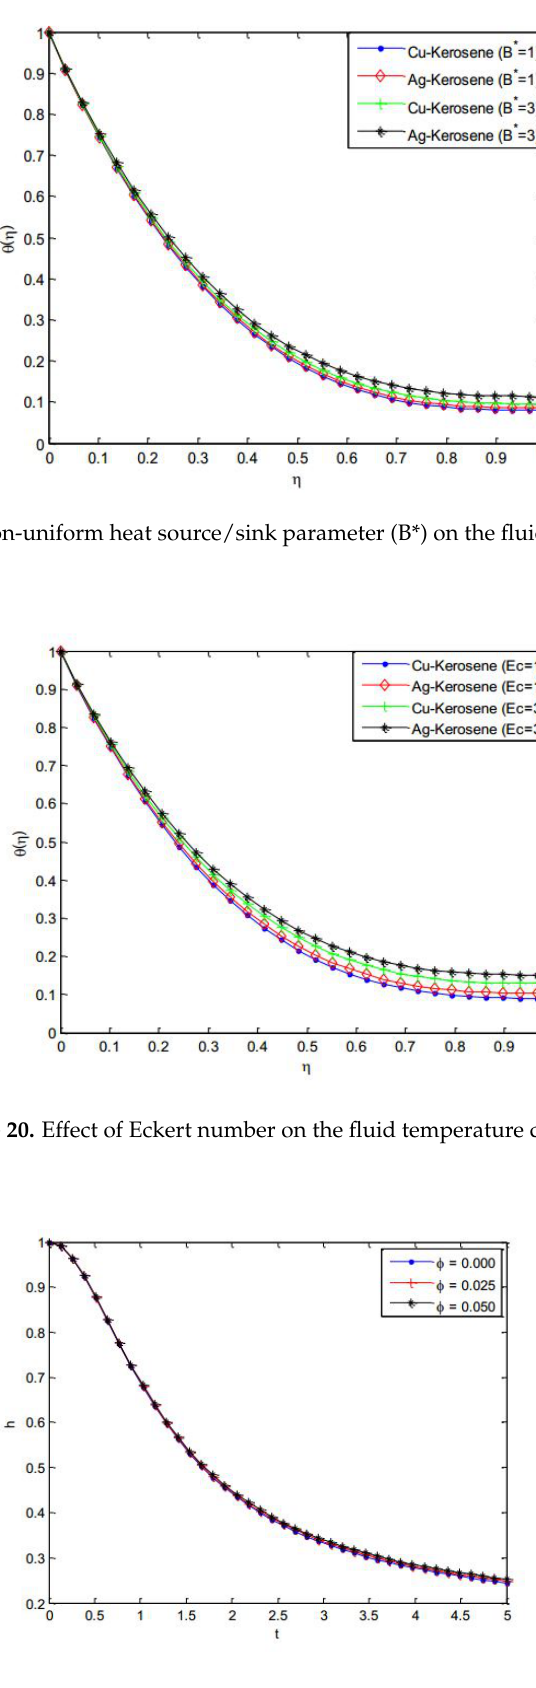
Figure 21. Variation of film thickness h with time t for different values of